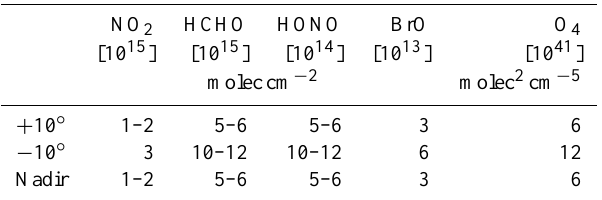
Table 2. Typical fit errors for slant column densities inside the cloud. Because the intensity in the − 10 ◦ spectrograph was lower the typical fit errors are higher compared to the other two spectro- graphs. The BrO fit error is included here to estimate the detection limit for bromine monoxide inside the